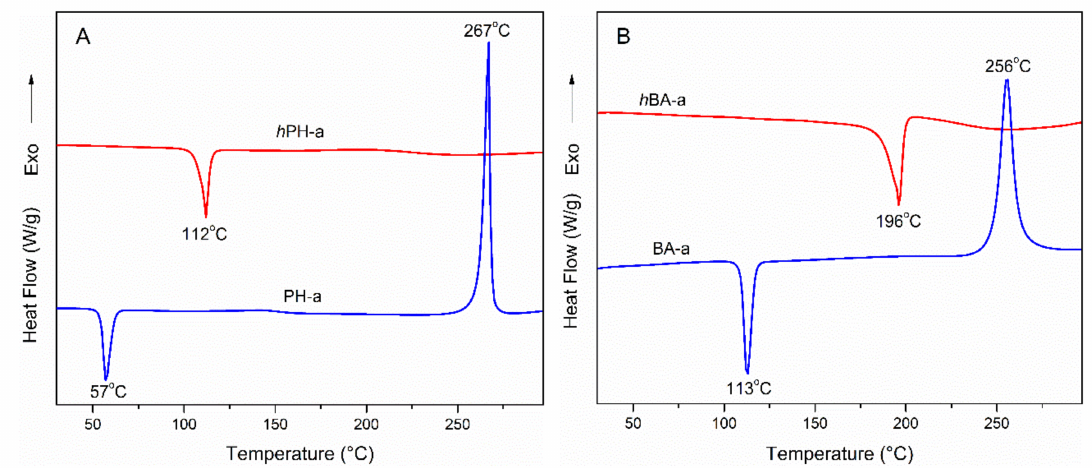
Figure 3. Di ff erential scanning calorimetry (DSC) thermograms of h PH-a and PH-a ( A ), h BA-a and BA-a ( B ).